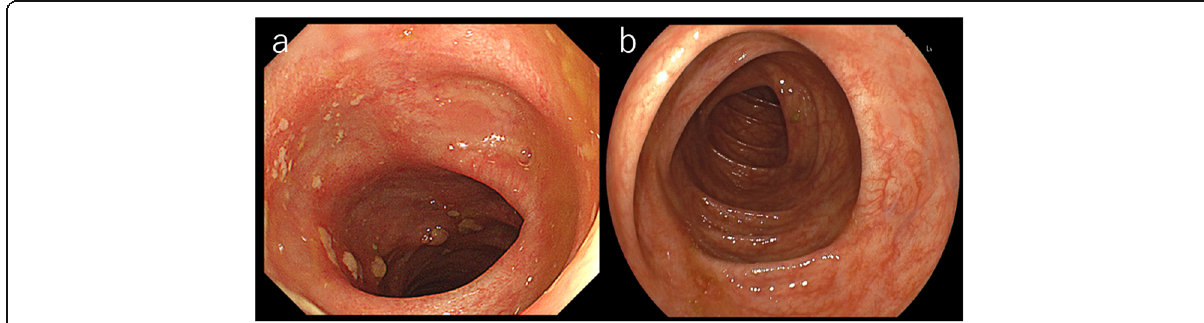
Fig. 6 a Colonoscopy on 3 months after surgery. The reddening and edematous changes are still remained on the descending colon. b Colonoscopy on 6 months after surgery. Obstructive colitis